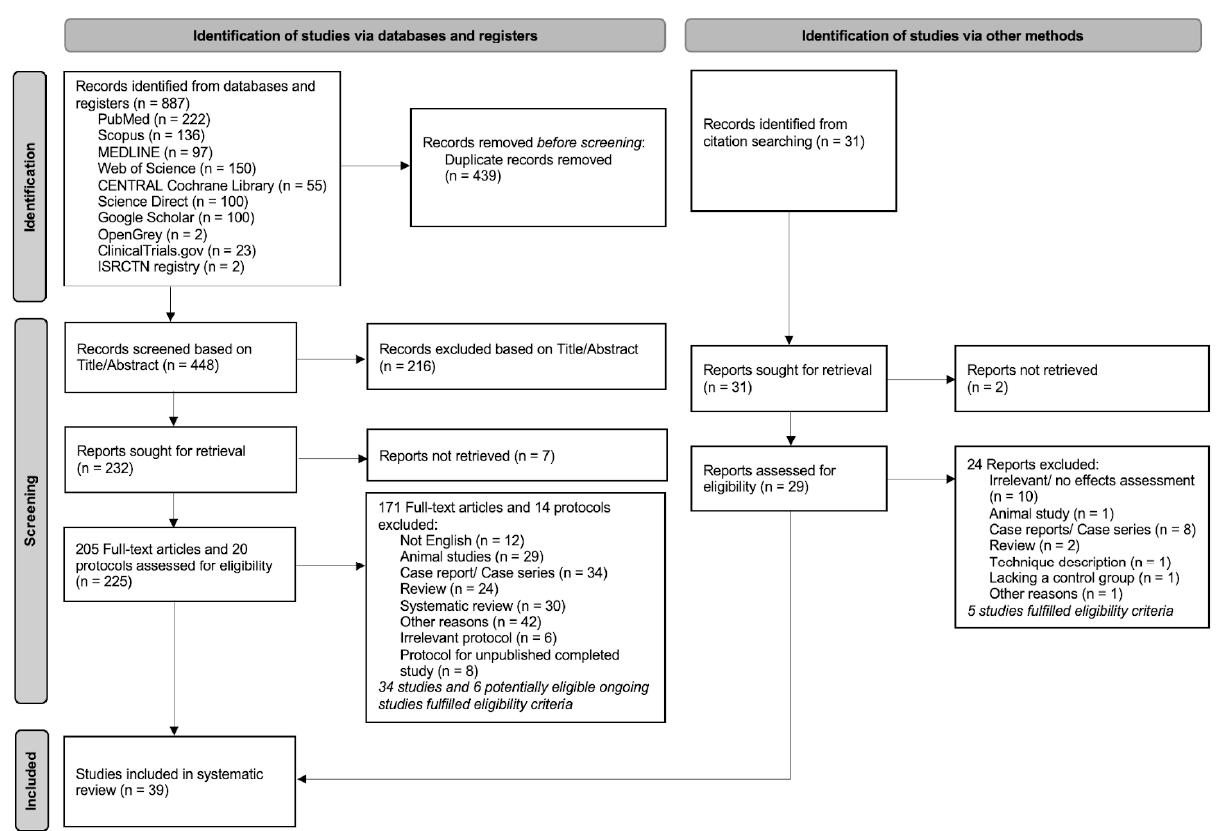
Figure 1. PRISMA 2020 flow diagram for new systematic reviews which included searches of databases, registers, and other sources.